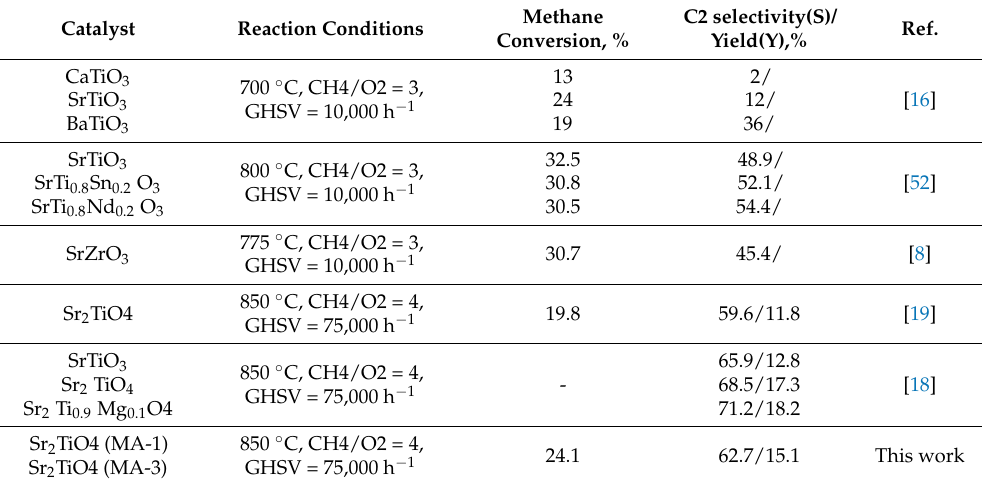
Figure 14. Methane and oxygen conversion, C2 and CO x selectivity, C2 yield in OCM for the samples annealed at 1100 ◦ C. The reaction mixture—CH 4 :O 2 :N 2 = 46:11.5:42.5% vol., CH 4 :O 2 = 4, GHSV = 75,000 h − 1 , 800–900 ◦ C. Table 3. Some recent studies on the OCM performance of different titanates with a perovskite